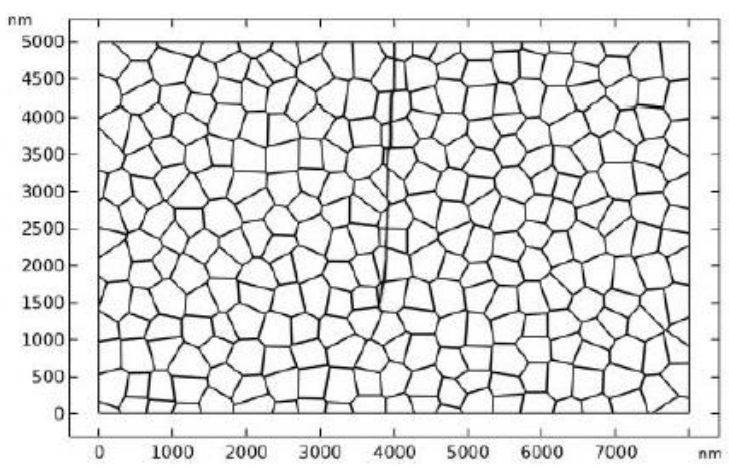
Figure 12. Crack propagation in linearly elastic material with “weak” GBs.